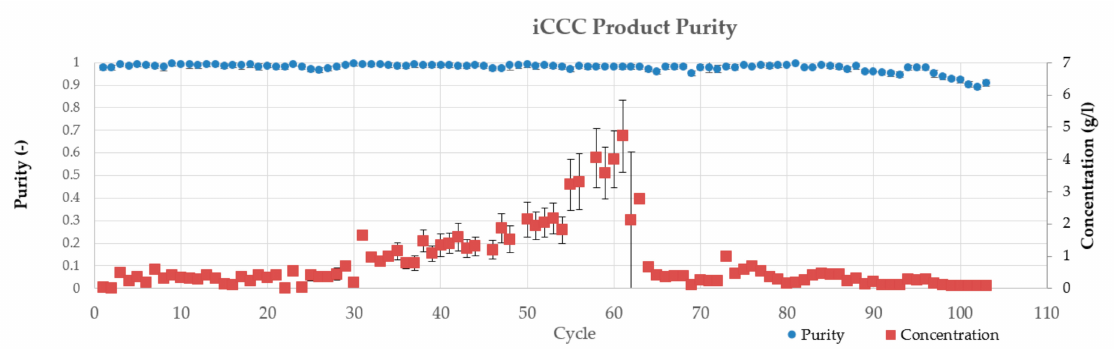
Figure 23. Product concentration and purity of the iCCC cycles. Error bars depict the double determination of the purity.